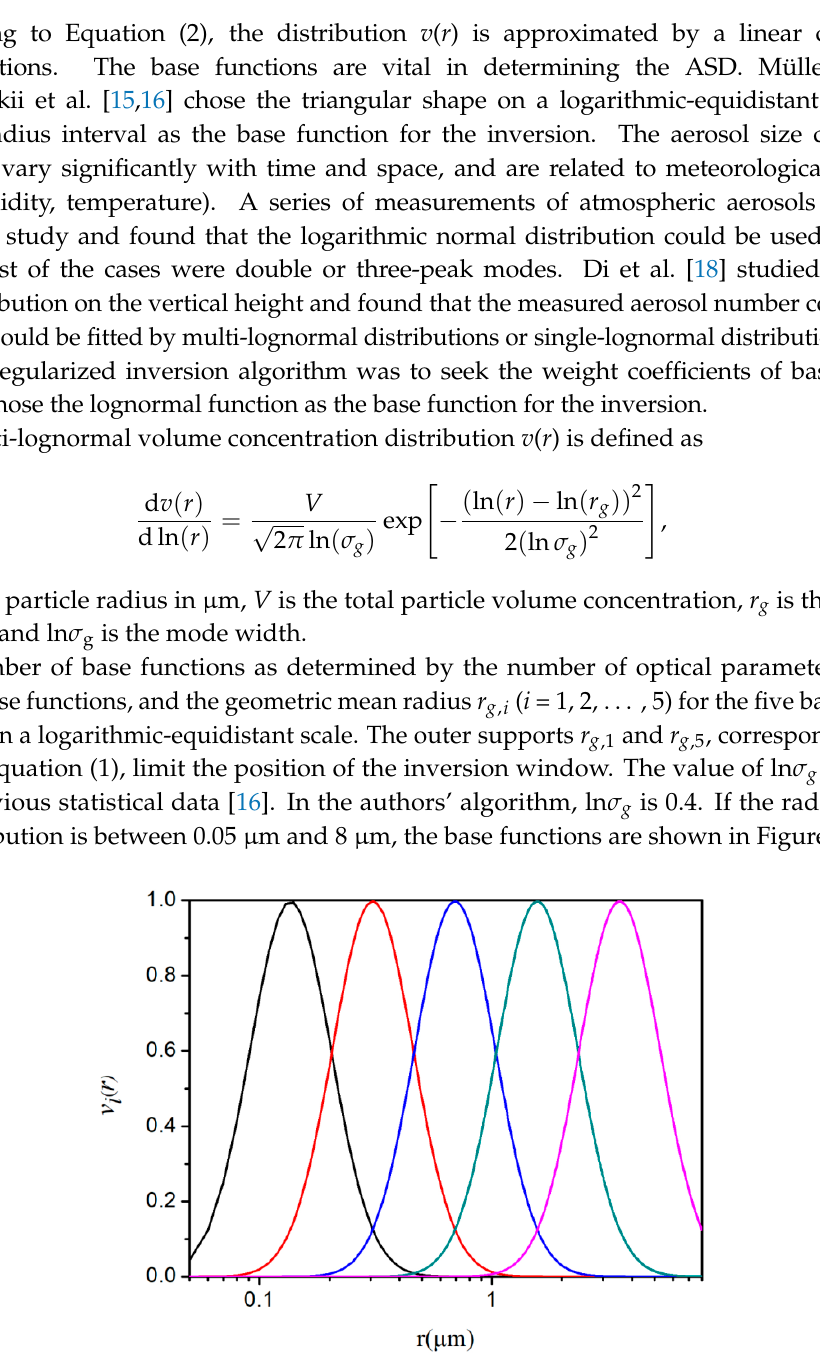
Figure 1. Base functions curve under a logarithmic scale. r g ,1 of the first function (black line) is 0.14 μ m, r g ,2 of the second function (red line) is 0.31 μ m, r g ,3 of the third function (blue line) is 0.69 μ m, r g ,4 of the fourth function (dark cyan line) is 1.57 μ m, and r g ,5 of the last function (magenta line) is 3.54 μ m.